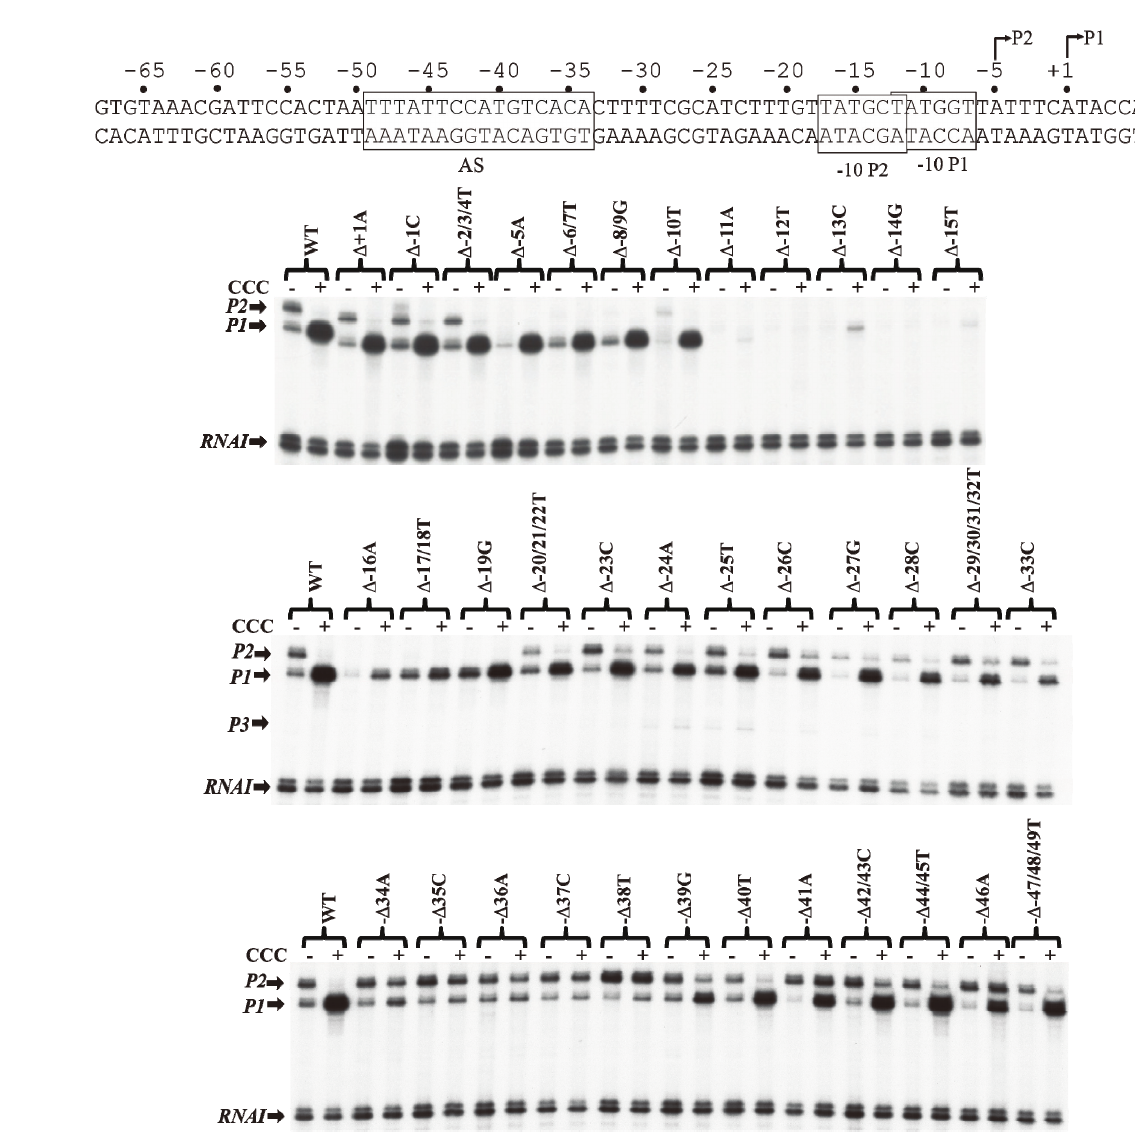
Figure 5. Effect of base pair deletions on in vitro transcription of gal promoters. ( A ) Sequence of gal DNA from (cid:2)68 to +6 with tsp of P2 ((cid:2)5) and P1 (+1). The (cid:2)10 element of P1 and (cid:2)10 element of P2 are boxed. The CCC site (AS) is also boxed; ( B ) mRNAs made from P1 and P2 from WT and mutant templates ((cid:6)(cid:2)1 to (cid:6)(cid:2)15) (reproduced with permission from John Wiley and Sons); ( C ) mRNAs made from P1 and P2 from WT and mutant templates ((cid:6)(cid:2)16 to (cid:6)(cid:2)33); ( D ) mRNAs made from P1 and P2 from templates with WT and mutant templates ((cid:6)(cid:2)34 to